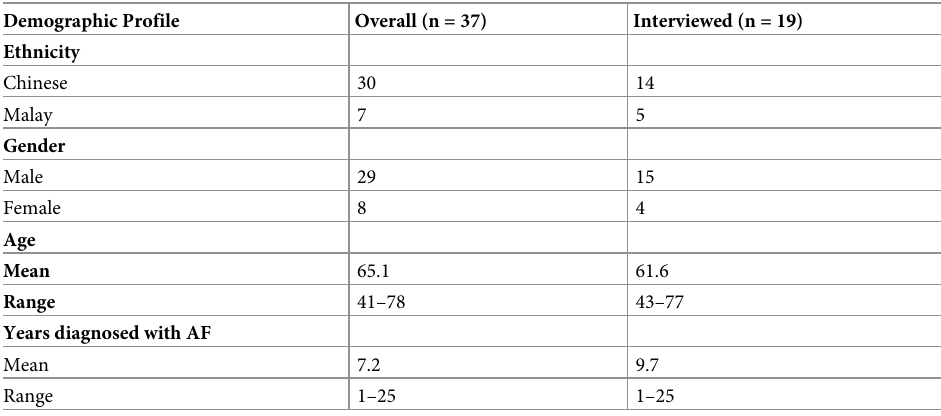
Table 2. Participant characteristics.